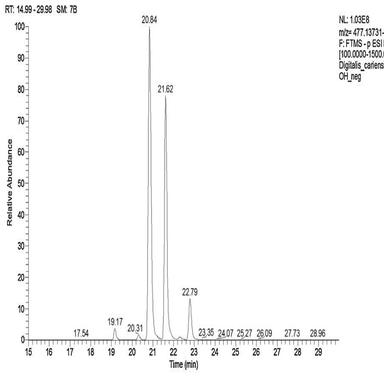
The typical extracted ion chromatogram at m/z 477.1397 in negative ion mode.